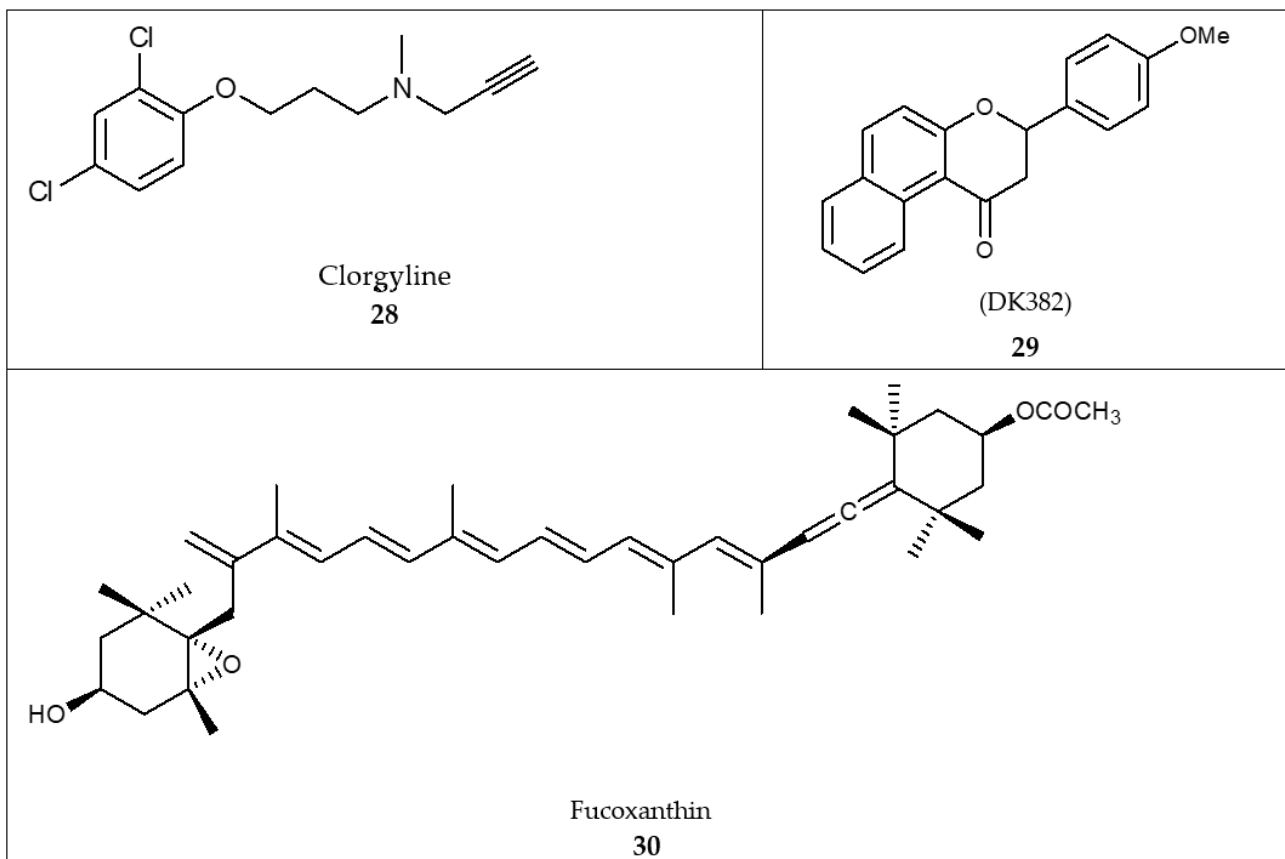
Figure 7. Structures of compounds designed employing in silico docking: clorgyline ( 28 ), DK382 ( 29 ), and fucoxanthin ( 30 ).